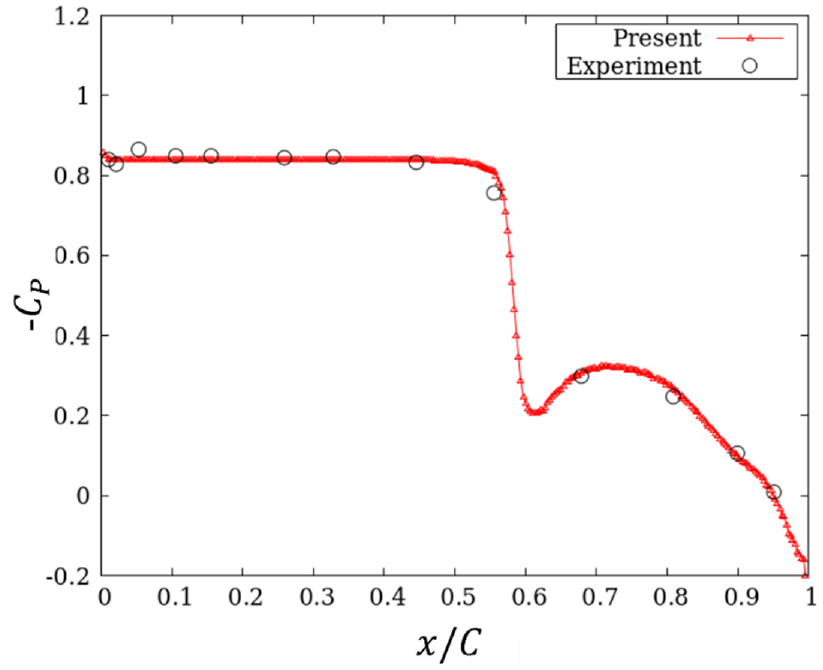
Figure 3. Pressure coefficient distribution on 2D modified NACA66 hydrofoil surface at σ = 0.84